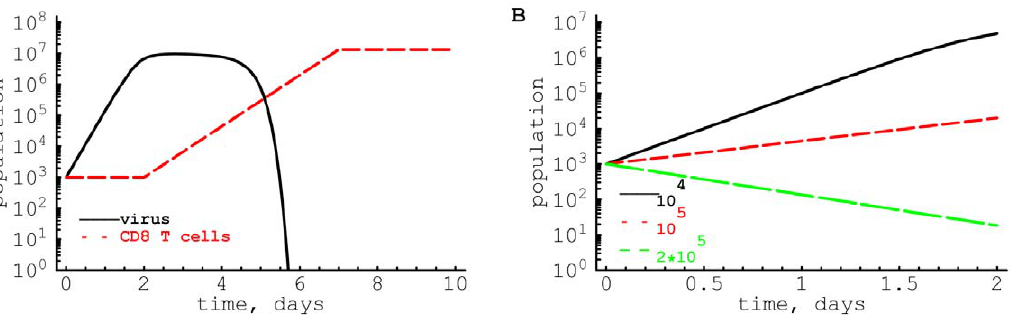
Figure 5. Predicted changes in viral load for different initial numbers of virus-specific memory CD8 + T cells. Using the model given in eqns. (3)–(4), we plot the dynamics of the virus ( V ) over the course of infection when the initial number of virus-specific memory CD8 z T cells ( E ) is low ( E 0 ~ 10 3 , panel A) or high ( E 0 ~ 10 4 ,10 5 , 2 | 10 5 , panel B). Viral density declines following infection as memory CD8 z T cells reach the threshold level of 1 : 3 | 10 5 cells per spleen. Other parameters are r ~ 5 day { 1 , C ~ 10 7 , k ~ 3 : 8 | 10 { 5 day { 1 , T on ~ 2 days , r ~ 1 : 9 day { 1 , T off ~ 7 days [29].